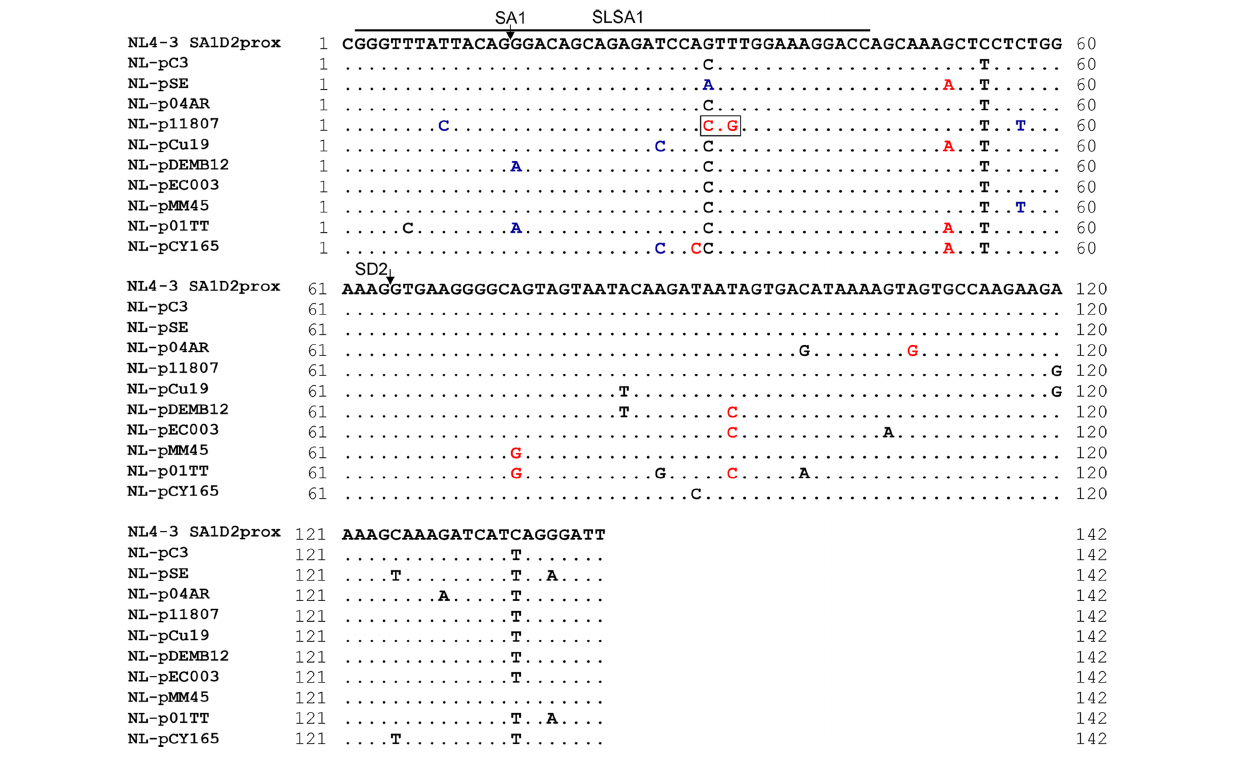
FIGURE 11 | Naturally occurring full-length SA1D2prox sequences analyzed in this study. Full-length SA1D2prox sequences derived from viral strains in the HIV-1 subtype B population are shown. NL-pC3 represents a consensus sequence of SA1D2prox in HIV-1 subtype B strains. SLSA1 region and SA1/SD2 sites are indicated. Blue and red letters show nSNVs that, upon introduction into NL4-3, phenotypically change it to the low and high vif types (Nomaguchi et al., 2016), respectively. The nSNVs that moderately affect vif expression level are indicated by black letters ( vif levels were from 0.5 to 1.2 relative to that by NL4-3). V234Lctg site is boxed. This variation contains two and one nucleotide substitutions relative to NL4-3 and NL-pC3,